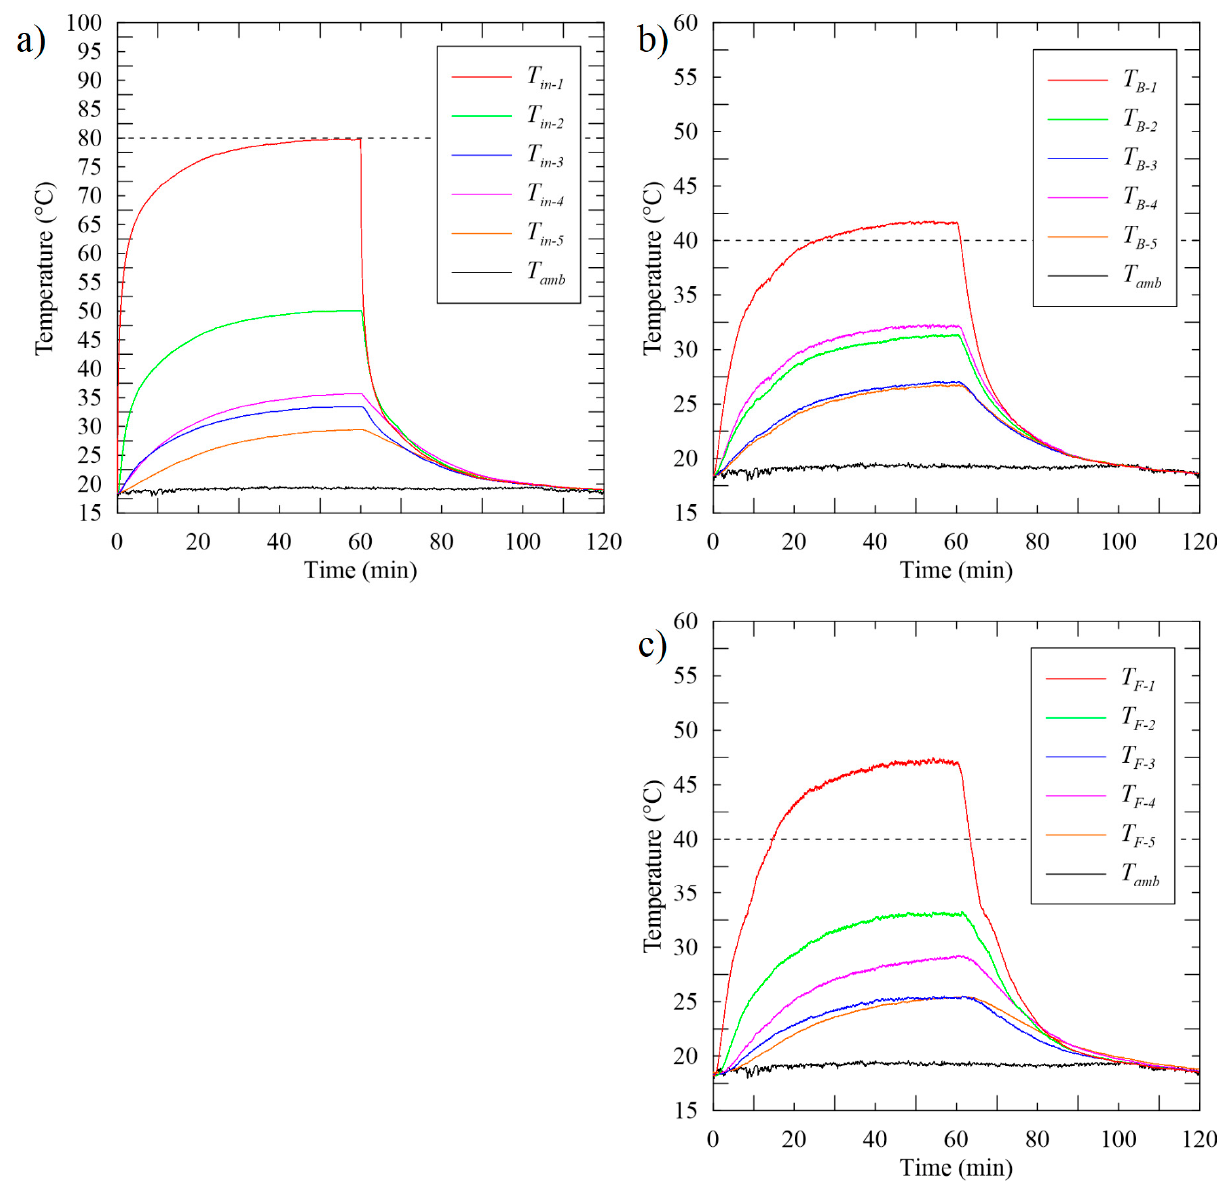
Figure 10. Temperature measurements on the ( a ) inside, ( b ) back cover, and ( c ) display of the mock tablet with an aluminum heat spreader, TIM, and a heat generation rate of 7 W (the dashed line represents the relevant temperature limit).